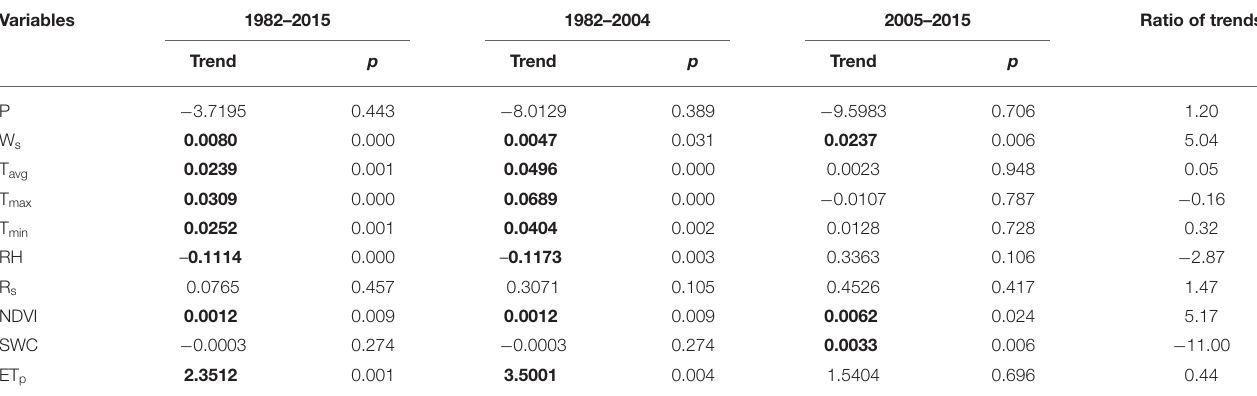
TABLE 1 | Linear trends of the investigated variables during three different periods at the annual scale.